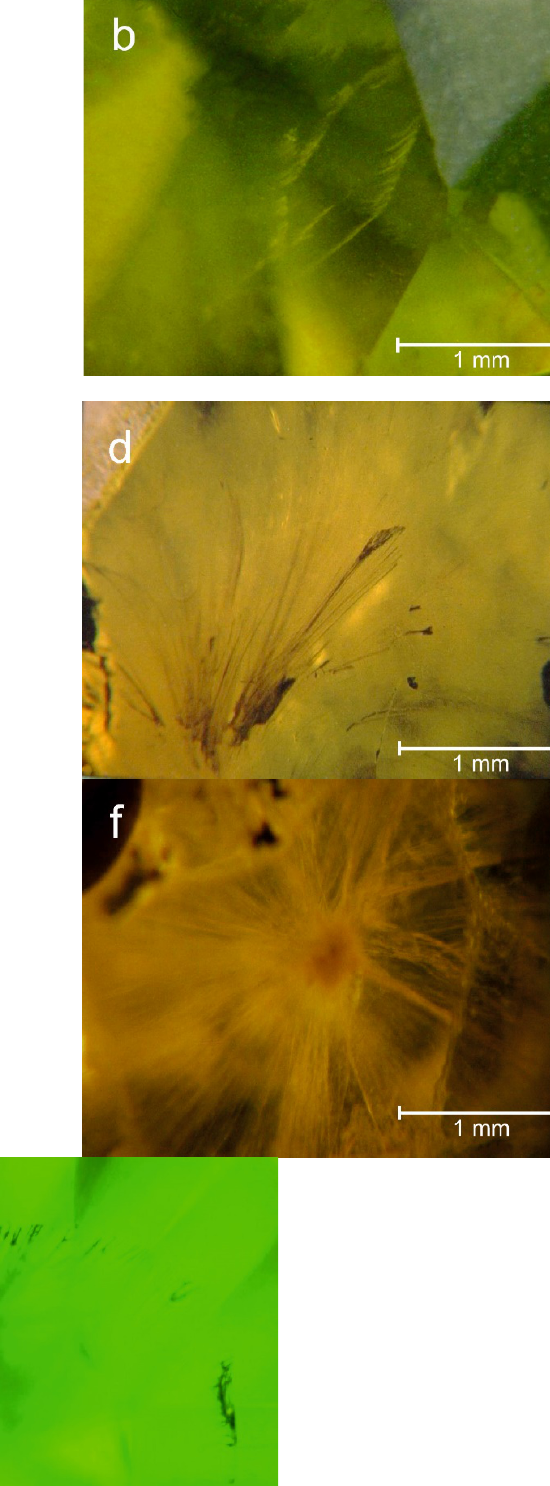
6 of 13 Figure 6. The demantoid crystal from the Ufaleiskiy manifestation. “Horsetail” inclusions are represented by hair-like formations of various sizes assem- bled in fan or sheaf-like bundles tapering toward the central part of the grain. Closely spaced inclusions form larger and denser formations. “Horsetail” inclusions may begin in the center of the grain from an inclusion of a dark ore mineral (chromospinel or magnetite, see Figure 2), or without a central inclusion. Sometimes “horsetail” inclusions start from a facet of the phantom, which can reflect (Figure 7a). “Horsetail” inclusions are often gath- ered not in a bundle (horsetail), but in a fan (Figure 7b). This can be seen especially well on the facets of the stone. They can start at any depth of the stone, with shallow “horsetail” inclusions often being v-shaped (Figure 7c). They are usually colorless and transparent,